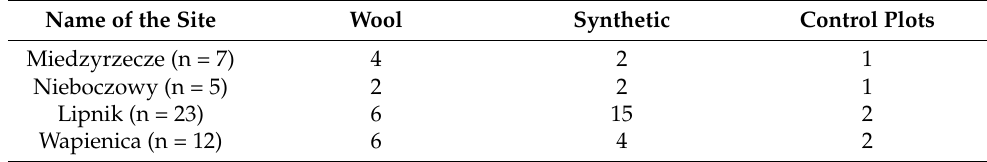
Table 2. The number of study plots at the investigated sites. Name of the Site Wool Synthetic Control Plots Miedzyrzecze (n = 7) 4 2 1 Nieboczowy (n = 5) 2 2 1 Lipnik (n = 23) 6 15 2 Wapienica (n = 12) 6 4